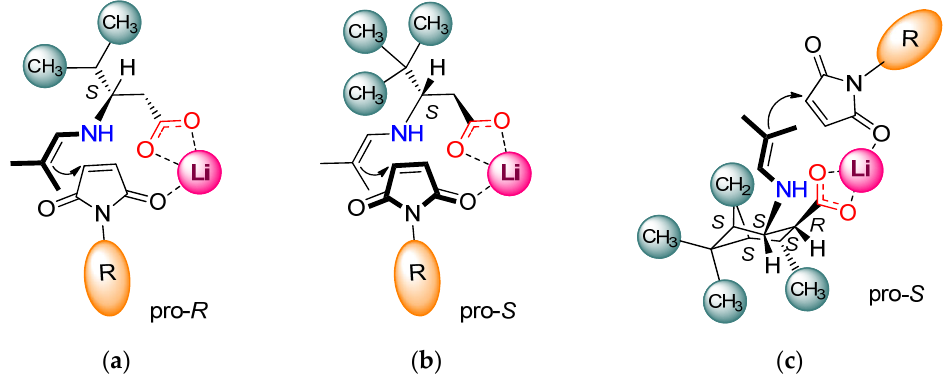
Figure 2. Proposed transition states formed in the asymmetric addition of 2 to N -substituted maleimides catalysed by β -amino acids in the presence of LiOH × H 2 O: ( a ) 6 ; ( b ) 7 ; ( c ) 14 . β -Amino acids with cyclohexane framework with the COOH and NH 2 groups